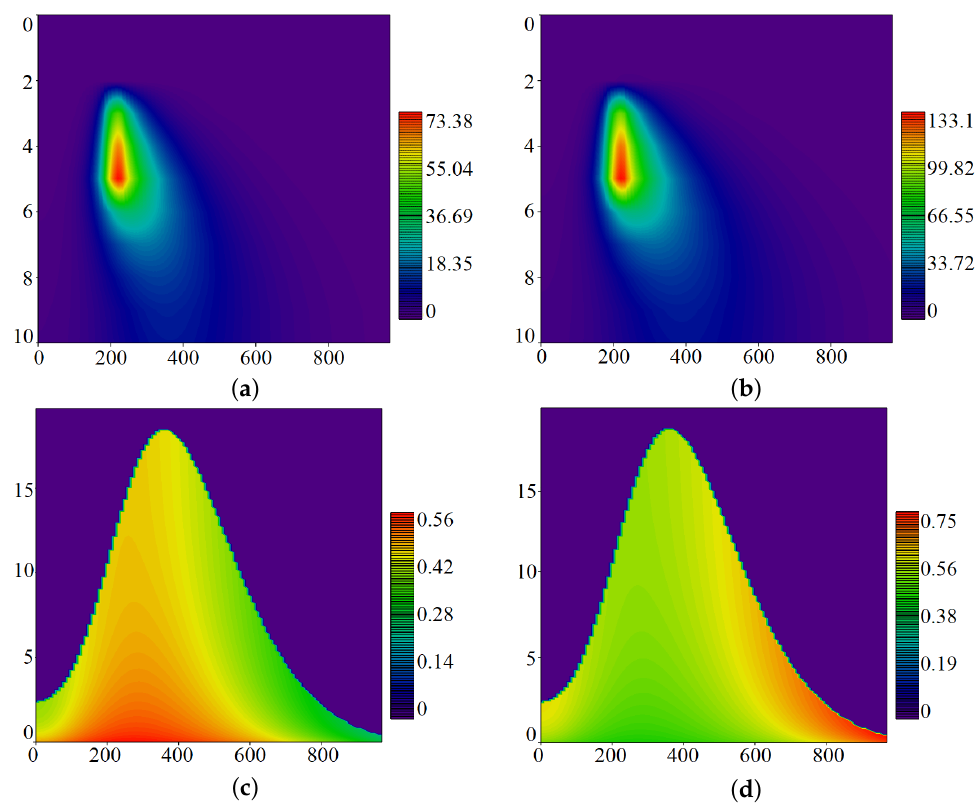
Figure 3. Dynamics of water flow changes in the estuary area. ( a ) concentrations of fraction A in the water; ( b ) concentrations of fraction B in the water; ( c ) concentration of fraction A in bottom sediments; ( d ) concentration of fraction B in bottom